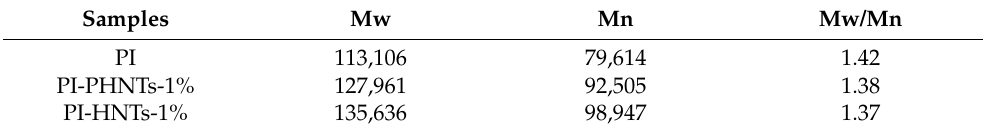
Table 1. The molecular weights and molecular weight distribution of PI, PI-PHNTs-1%, and PI-HNTs-1%.